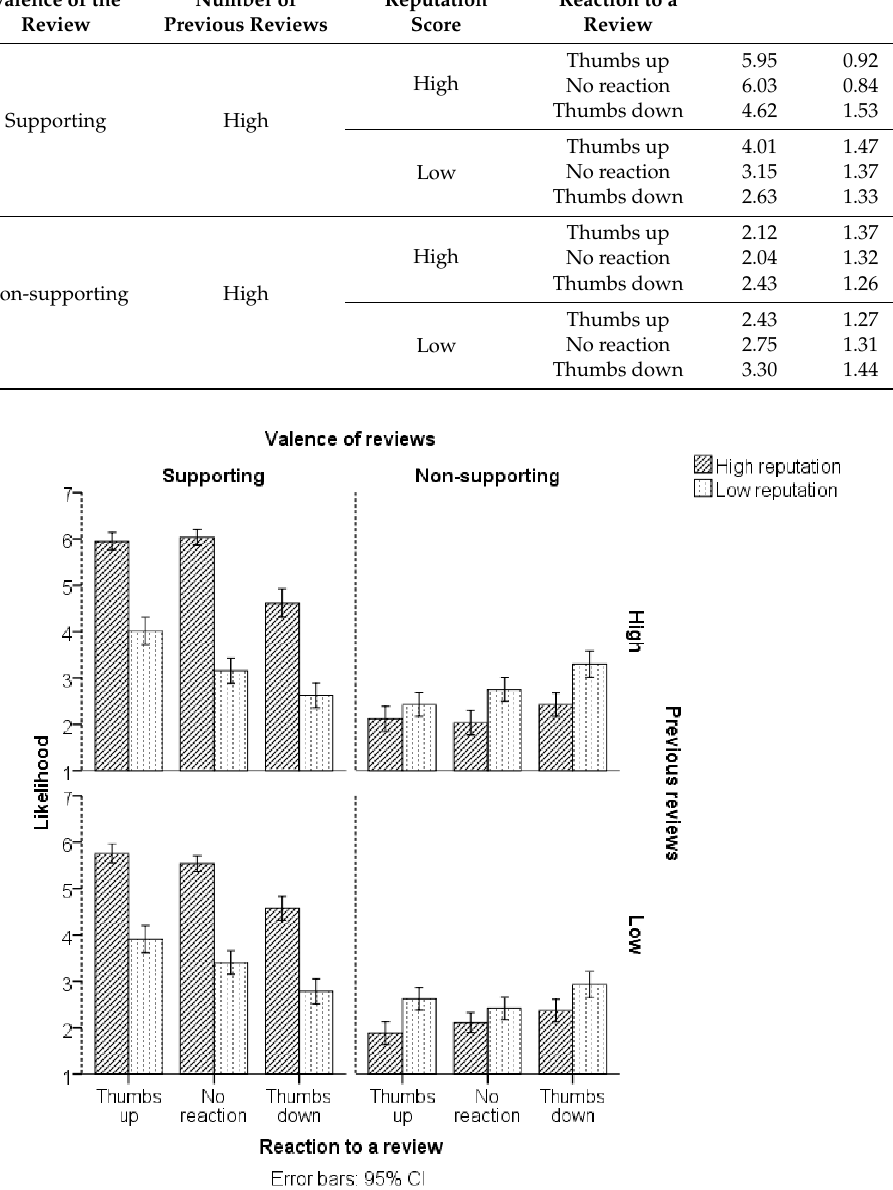
Figure 7. Effect of reaction to a review, reputation score, number of previous reviews and valence of reviews on likelihood score.